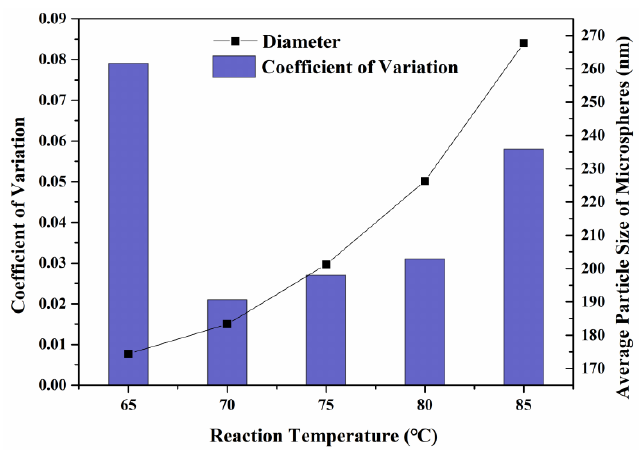
Figure 7. FE-SEM images were manually measured to characterize the average particle size of PSt microspheres synthesized at different